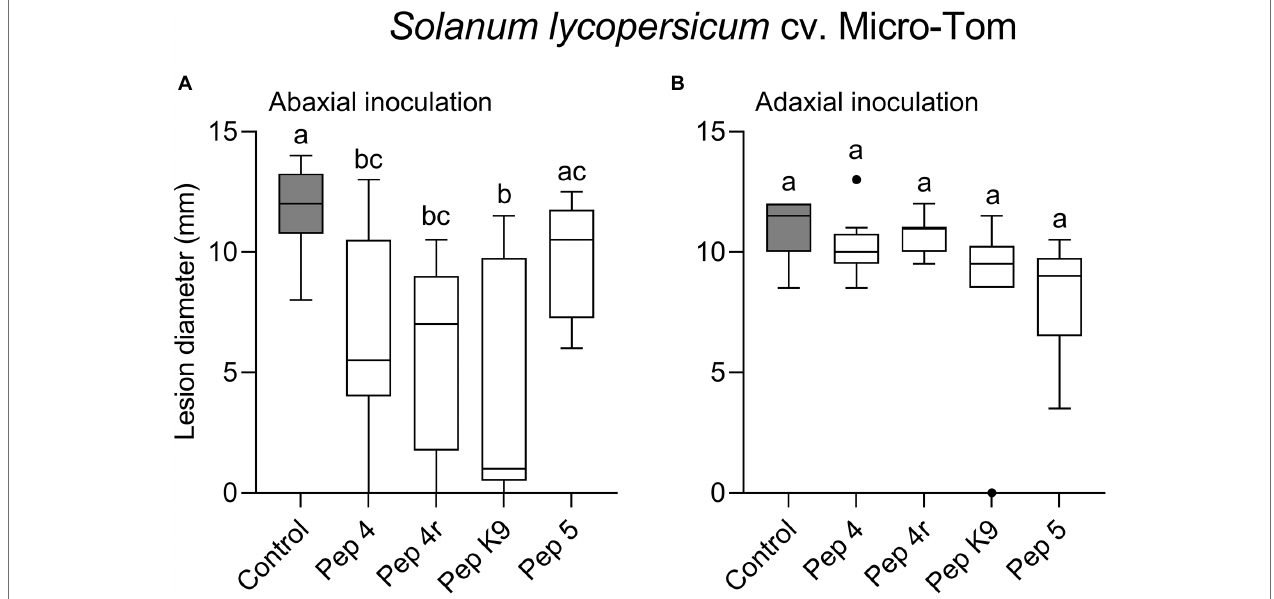
FIGURE 2 | Preventive efficacy of selected Trichogin GA IV-derived peptides against Botrytis cinerea infection on Solanum lycopersicum cv. Micro-Tom leaves. Treatments were performed by spraying the lower (abaxial) surface with 50 μ M peptide solution in water. The pathogen was inoculated 48 h later by drop inoculation with a conidial suspension of B. cinerea . Conidia were applied on the abaxial (peptide-treated; A ) or adaxial (untreated; B ) leaf surface. Lesion diameters were measured 3 days after infection. Control leaves were treated with water. Values from nine biological replicates are reported as Tukey boxplots. Data were analyzed by one-way ANOVA with Tukey–Kramer post-test ( p < 0.05). Statistically significant differences are shown by different letters. The experiment in (A) was repeated with similar